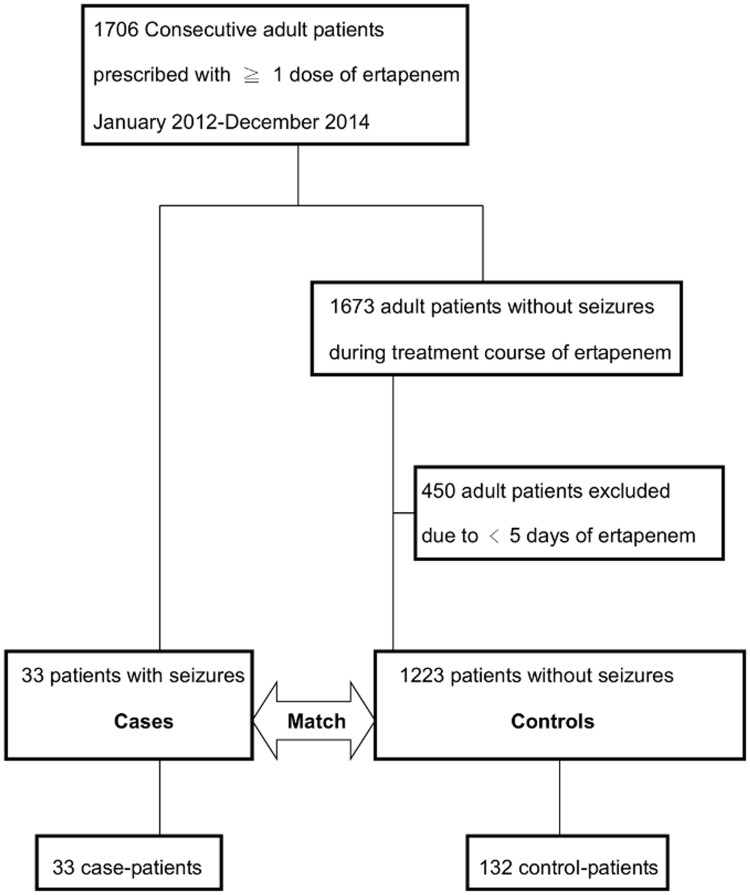
Flow chart of participants with or without seizures included in the analysis.